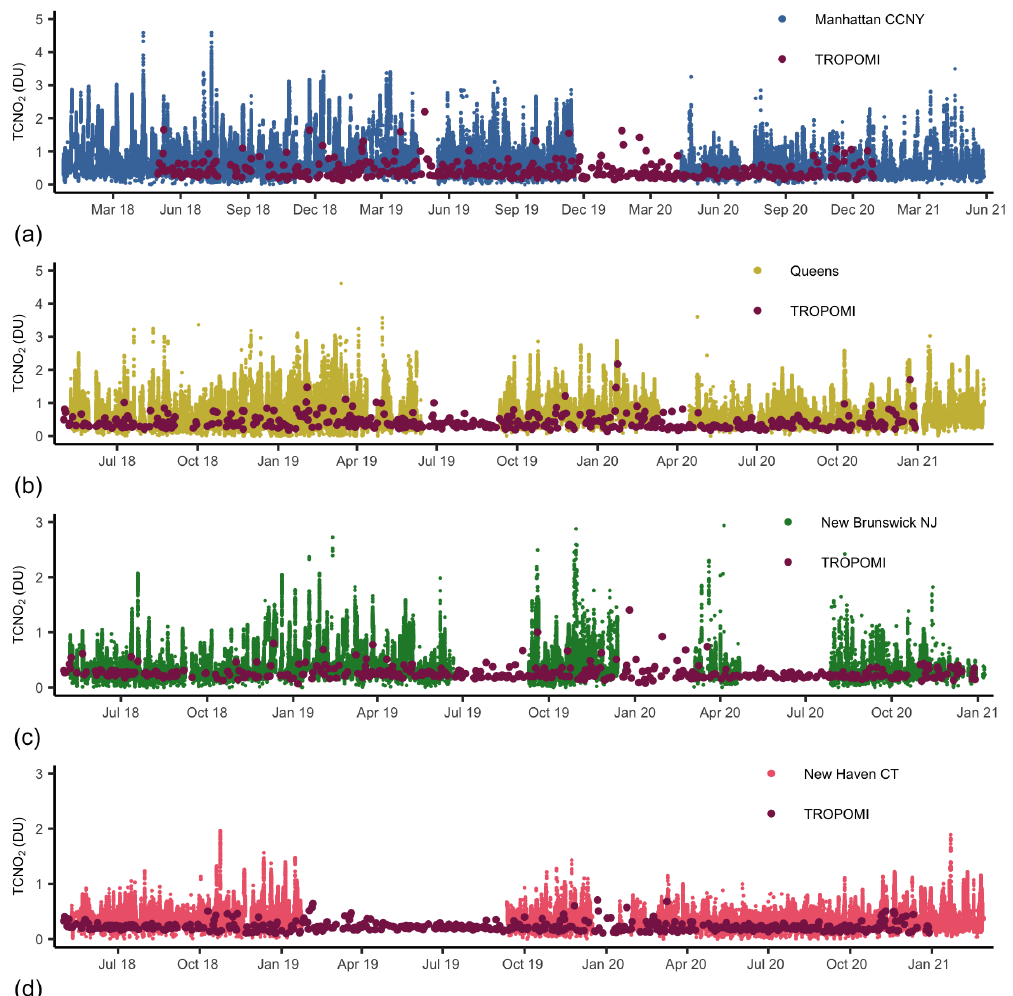
Figure 3. Long term (December 2017–February 2021, May 2021 in Manhattan only) data record of TCNO 2 (in DU) measured by Pandoras in (a) Upper West Side Manhattan (blue circles), (b) Queens (yellow circles), (c) New Brunswick NJ (green circles) and (d) New Haven CT (pink circles). Total column TROPOMI overpass data at locations of the Pandora instruments is also shown (red circles). No data averaging was performed on Pandora or TROPOMI